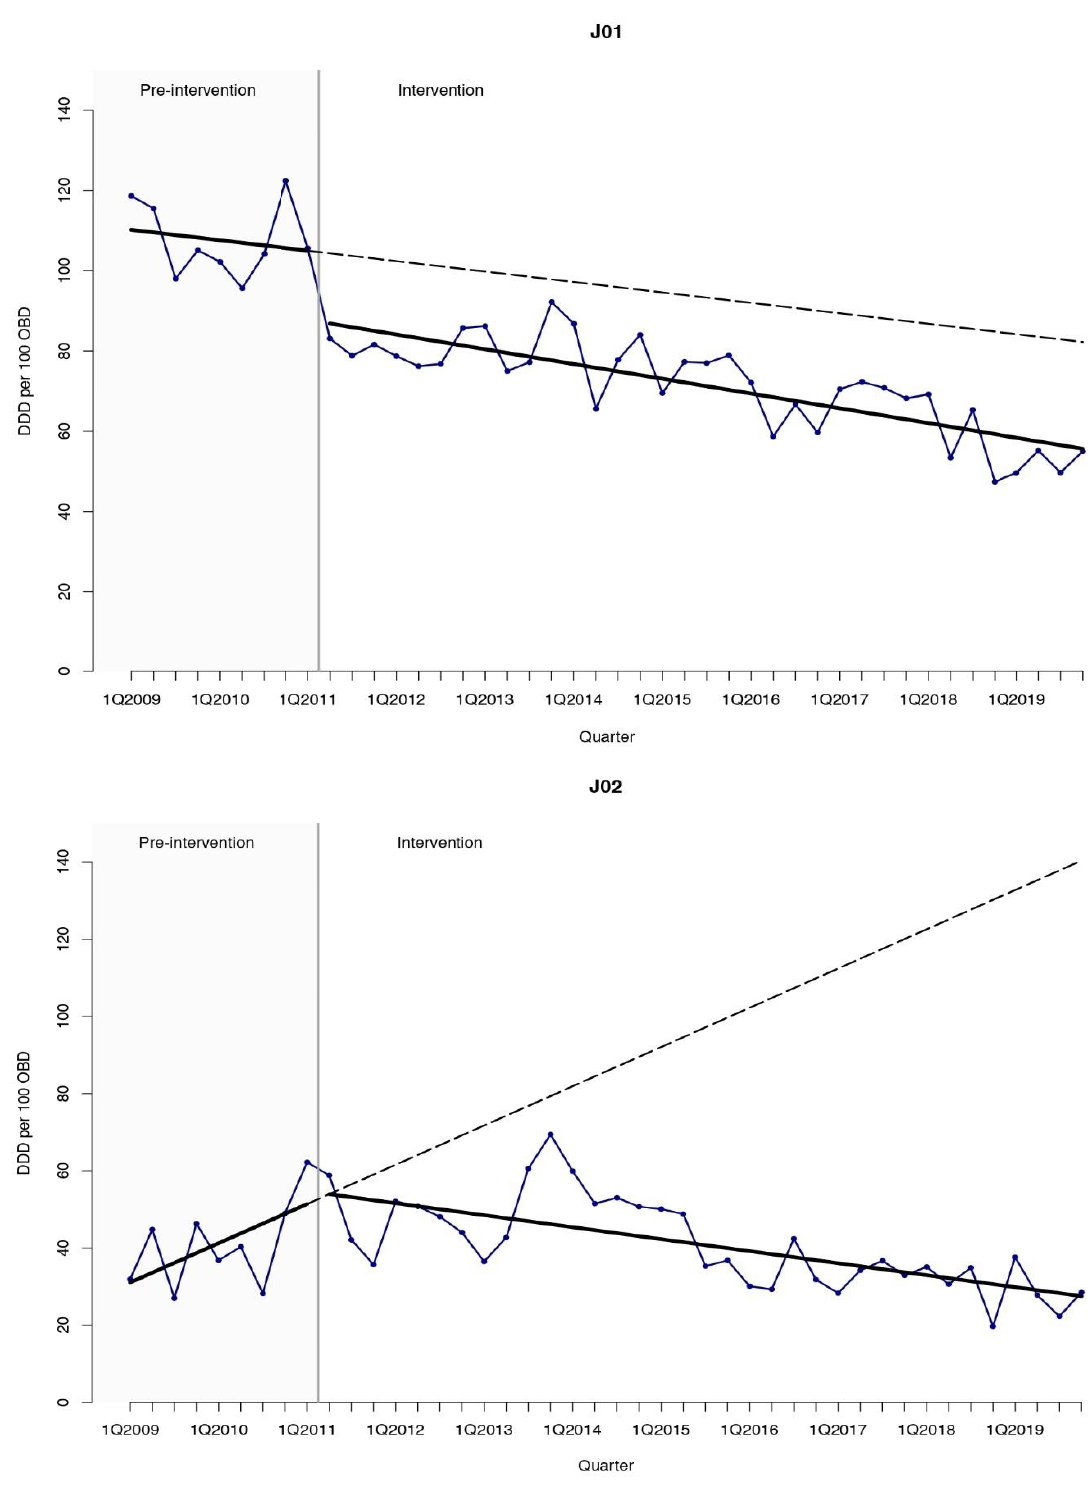
Figure 2. Interrupted time-series analysis of the trends in consumption for antibacterials for systemic use ( J01 ) and antifungals ( J02 ) observed before and after the implementation of the antimicrobial stewardship program. Solid lines show the observed trend during the pre-intervention and intervention periods. Dashed lines show the expected trend after the intervention according to the pre-intervention values. DDD, defined daily doses. OBD, occupied bed days. Q, quarter.